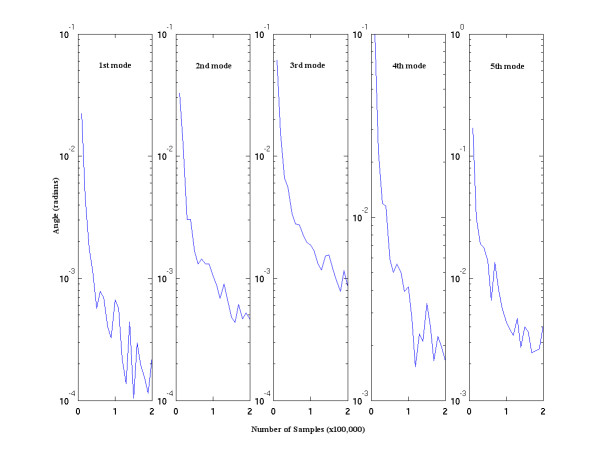
The SVD procedure was applied for increasingly larger sample sizes (up to 200,000 in increments of 10,000) for the metabolic network of the bacterium Helicobacter pylori and the first five modes at each sample size were recorded. These plots show the convergence of the angle between the modes for subsequent sample sizes.